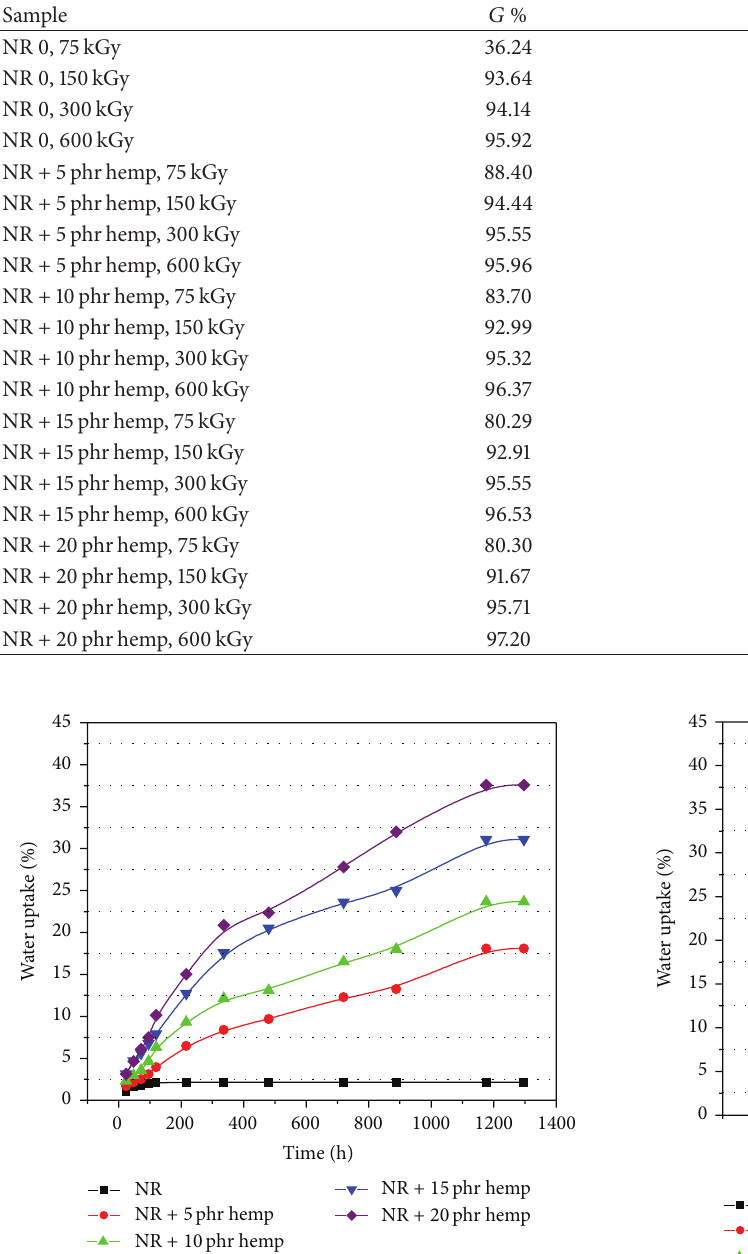
Table 1: Gel content ( 𝐺 %), volume fractions of polymer ( ] 2𝑚 ), and crosslink density ( ] ) of samples.